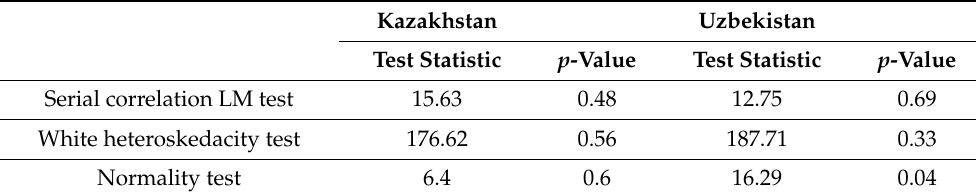
Table 6. Diagnostic tests of VEC model